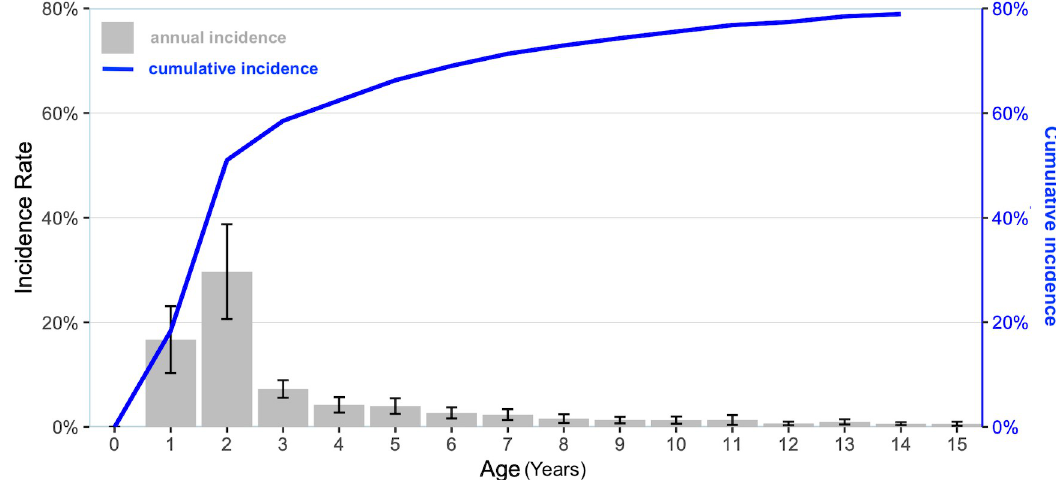
Fig 2. Scabies incidence rate by age group and cumulative incidence from 0 to 15 years. The histogram represents the average scabies incidence rate by age group; the curve represents the cumulative incidence of scabies from 0 to 15 years.